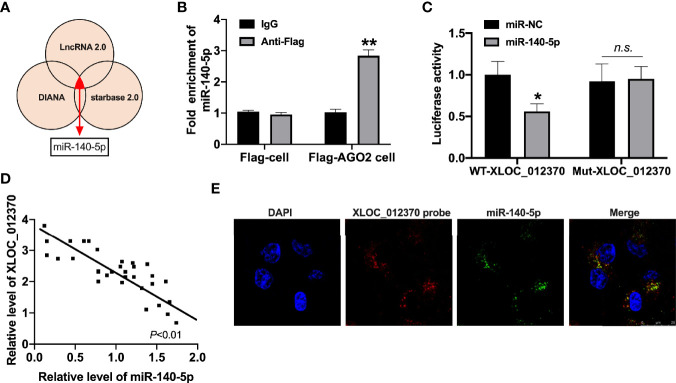
LncRNA XLOC_012370 interacts with miR-140-5p. (A) Bioinformatic target prediction was performed with three online tools. (B) Binding situation between XLOC_012370 and miR-140-5p verified using RNA pull-down. n=3, *P < 0.05, **P < 0.01. (C) Luciferase assay was performed in the relationship between XLOC_012370 and miR-140-5p. n=3, *P < 0.05. (D) Pearson analysis of the correlation of miR‐140‐5p with XLOC_012370 expression in tumor tissues. n=30. (E) Co-localization between XLOC_012370 and miR-140-5p was revealed by fluorescence in situ hybridization. n.s. means not significant.